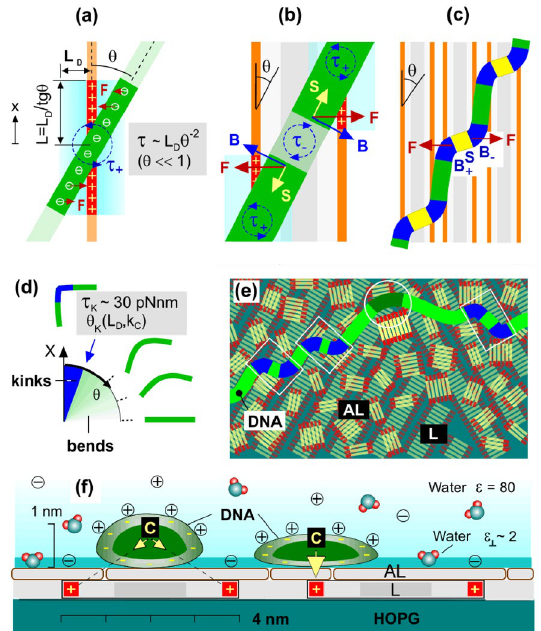
Fig. 3 Schematics of DNA bending and kinking induced by the lat‑ eral DNA/surface electrostatic interaction (θ ≠ 0). a The distribution of screened electrostatic forces (red arrows) along the DNA crossing a sin‑ gle row of positive charges; L D is the length of (salt‑dependent) elec‑ trostatic screening. b The force and torque distribution along the DNA segment crossing the charged lamella with an inclination θ. c The shape of inclined DNA; the highly bent (B) and stretched (S) segments are, respectively, shown by intense blue and yellow. d Bends/kinks phase diagram depending on the inclination angle in the homogeneously charged rod model; Θ K is the salt‑dependent critical inclination for the kink formation. e The general model of DNA bending induced by the lateral electrostatic interaction with the underlying lamellar layer (L) and with large GA oligomers in the upper adlayer (AL); the bending units are, respectively, selected by rectangles and circle. f The DNA/ AL/L/HOPG interfacial geometry in cross section (approximately in the scale). The ions attached to DNA and amines symbolize the counterions condensation effect reducing the DNA‑lamella lateral electrostatic inter‑ action. The electrostatic compression force (yellow arrows) depends on the intralamellar DNA position. Oriented water dipoles symbolize inter‑ facial dielectric effect amplifying the compression